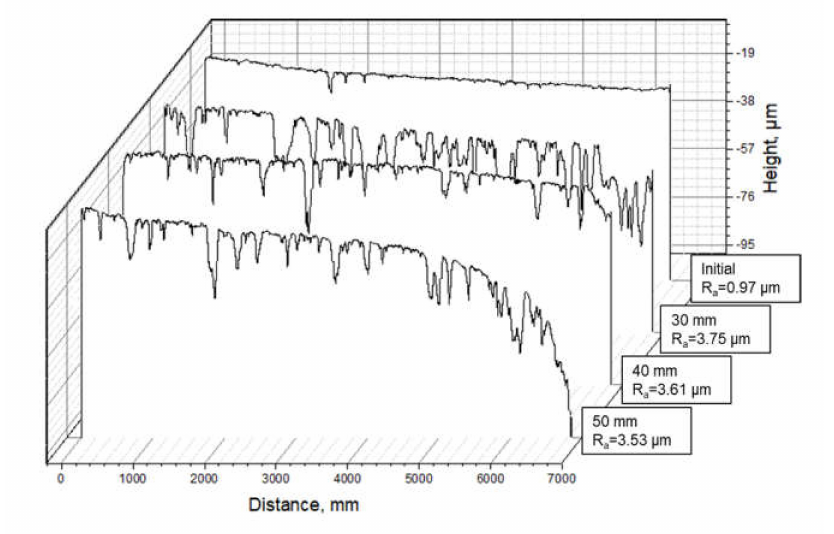
Figure 7. Surface roughness of the coating before and after pulsed-plasma treatment, depending on the distance from the plasma